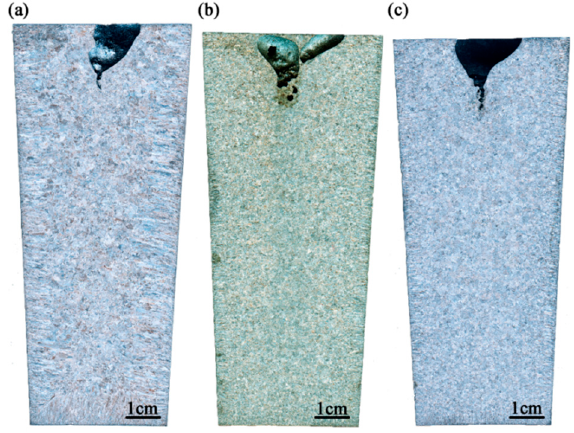
Figure 2. As-cast structure of three ingots: ( a ) S1 with no Ti addition; ( b ) S2 with 0.2 mass% Ti; and ( c ) S3 with 0.45 mass% Ti (online version in color).